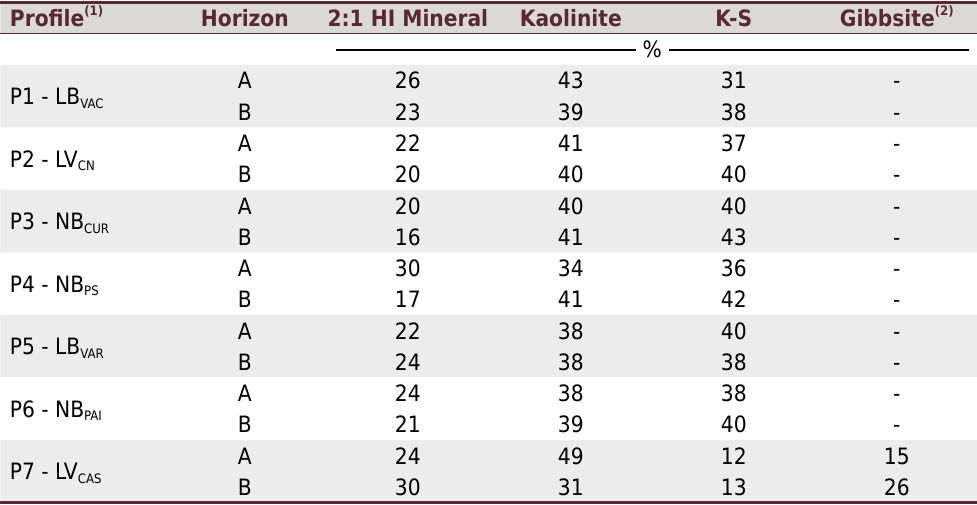
Table 4. Values of the minerals that compose the samples, estimated by NEWMOD ® software for the A and B horizons of the profiles studied, in the total clay fraction